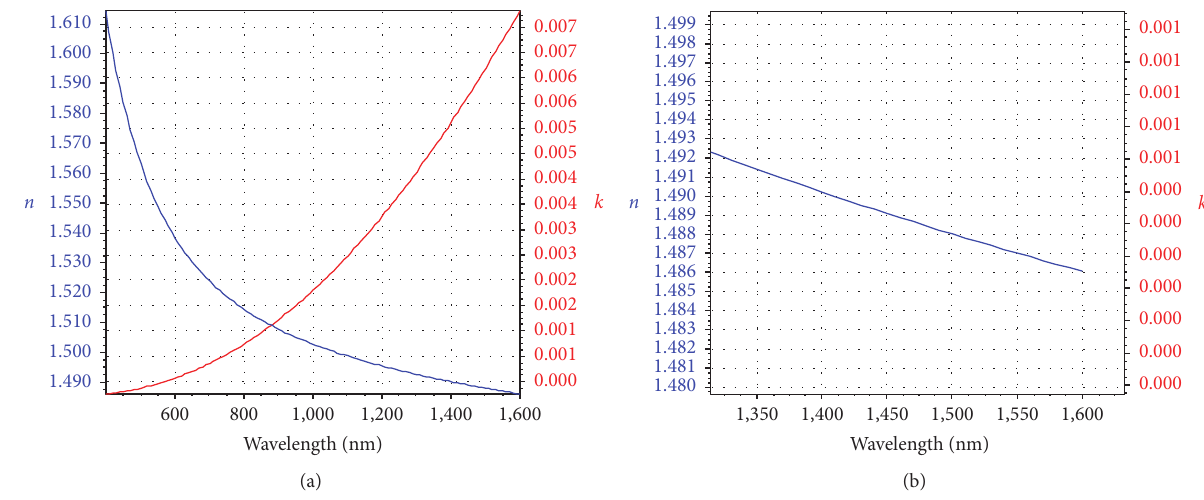
Figure 7: (a) The refractive index (real part ( 𝑛 ) and imaginary part ( 𝑘 )) of TiO 2 NMO as a function of the incident wavelength as a result from the spectroscopic ellipsometry for the sample prepared in Section 3.1 (TiO 2 NMO preparation method). (b) Magnification of the real part of the refractive index of TiO 2 NMO.